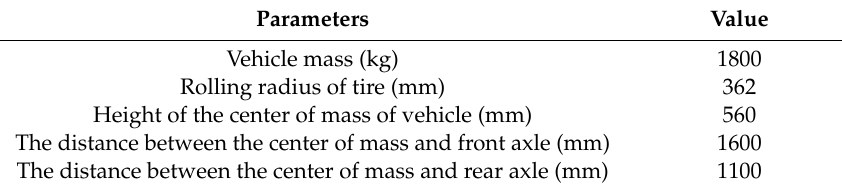
Figure 1. Structure of a four-wheel-drive pure electric vehicle. Table 1. Parameters of the vehicle.